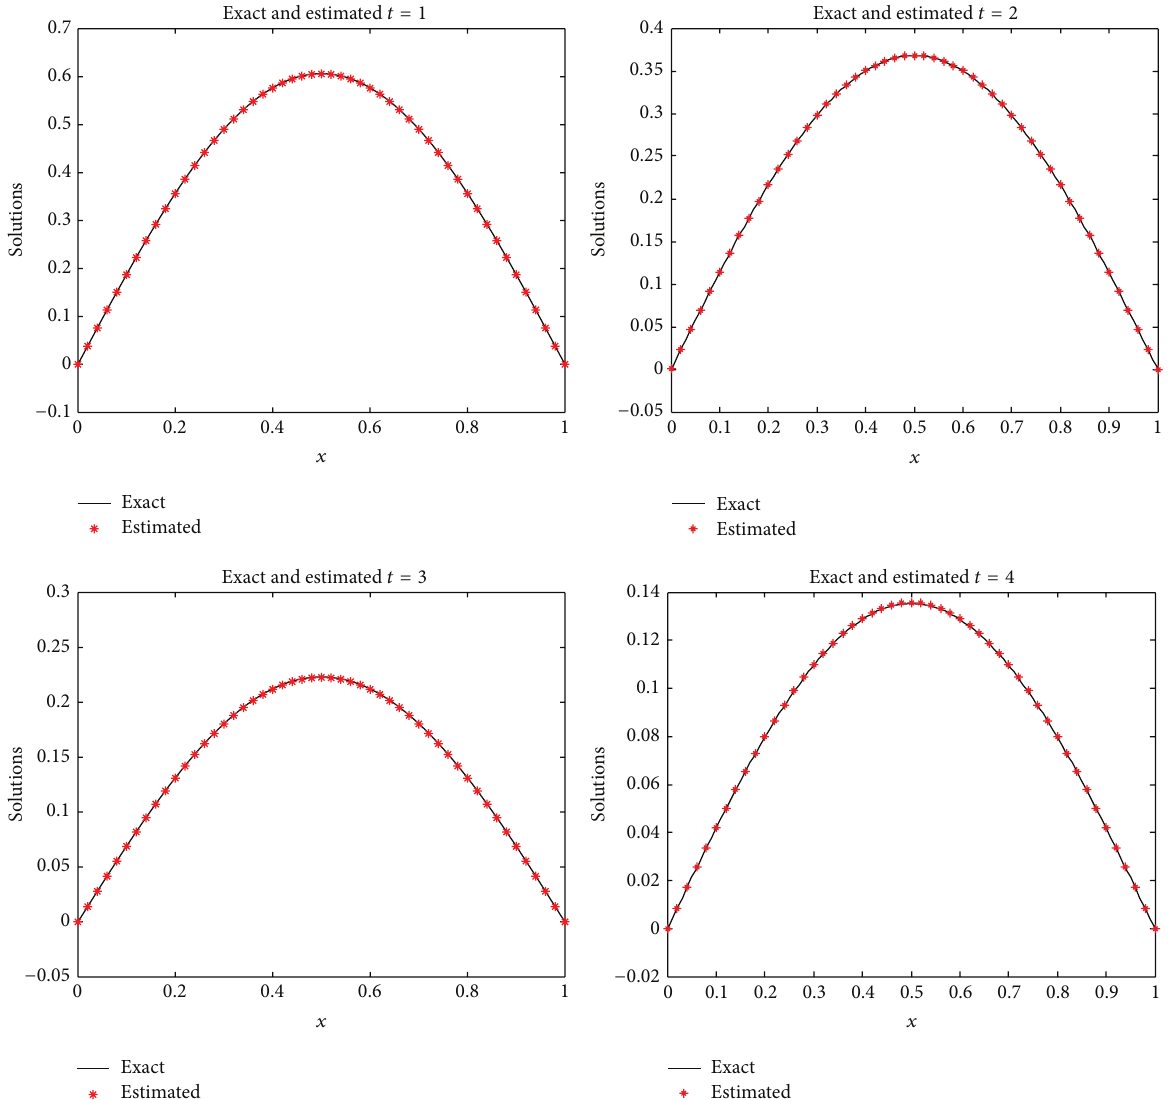
Figure 3: Space-time graph of numerical and analytical solutions at time 𝑡 = 1,2, 3, 4 with 𝑑𝑥 = 0.01 , 𝑑𝑡 = 0.001 and using IMQ (with 𝑐 = 0.08 ) as the radial basis function for Example 3